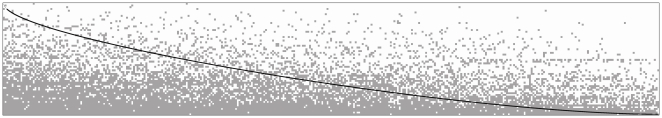
Maximally packed presence-absence matrix of Caribbean reef fishes, such that species are sorted in order of ubiquity (rows) and sites are sorted in order of richness (columns).Each darkened square indicates the presence of a species at a site. The curve represents the isocline of perfect nestedness subject to the constraints of perfect occupancy at the most diverse site, and perfect vacancy at the least diverse site.